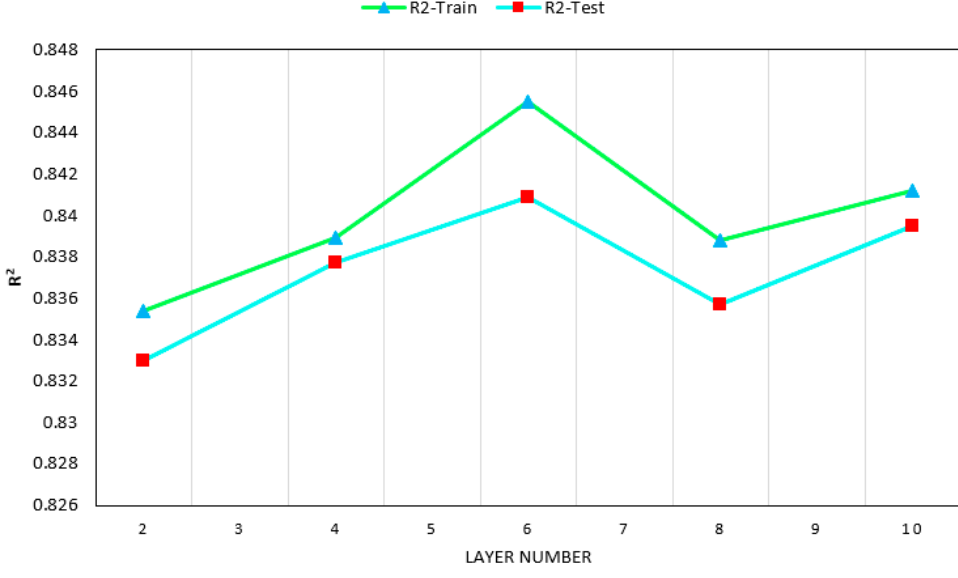
Figure 6. Impacts of the layer number on the performance of GMDH models.